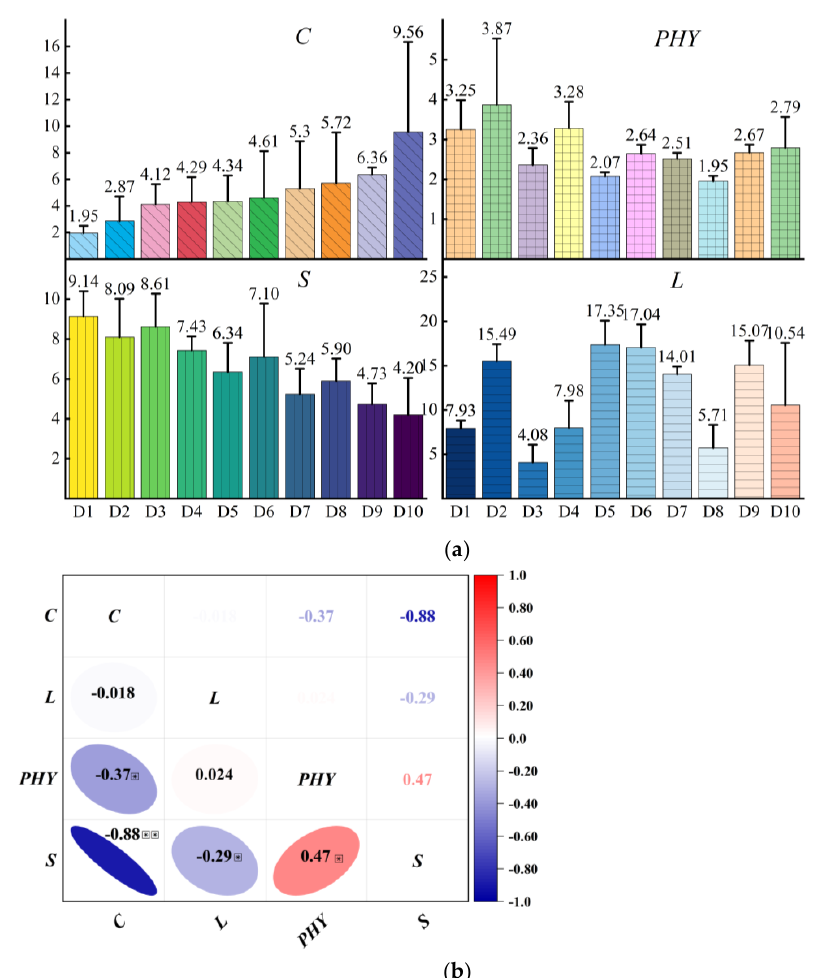
Figure 6. ( a ) The trend of plant architecture vectors consisting of four plant architecture indices ( C, PHY, S, and L ). ( b ) Correlation among plant architecture vectors.